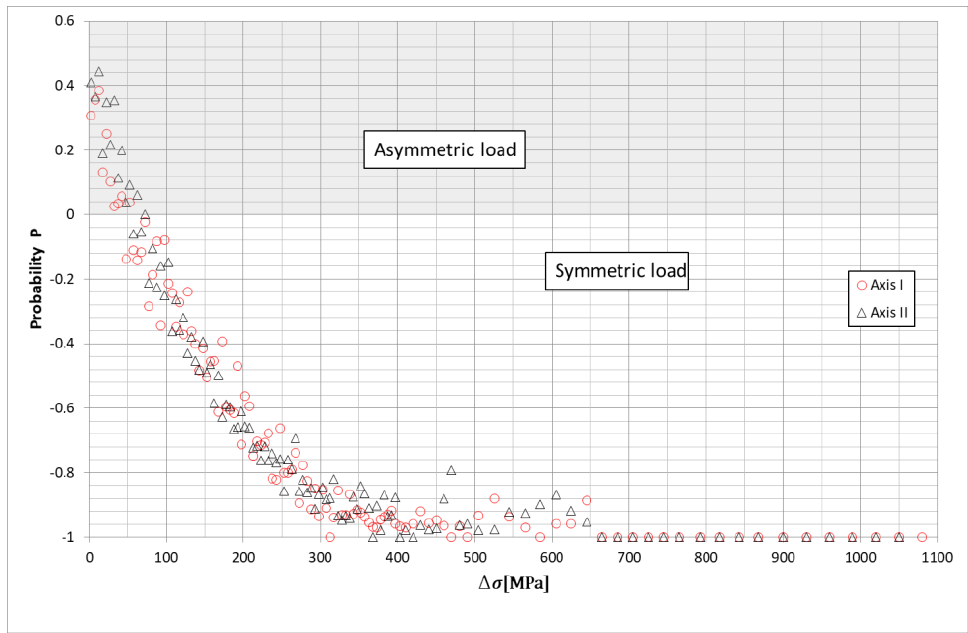
Figure 9. Comparison of probabilities of the occurrence of cases with corresponding stress ranges for both axes for symmetric and asymmetric examples.